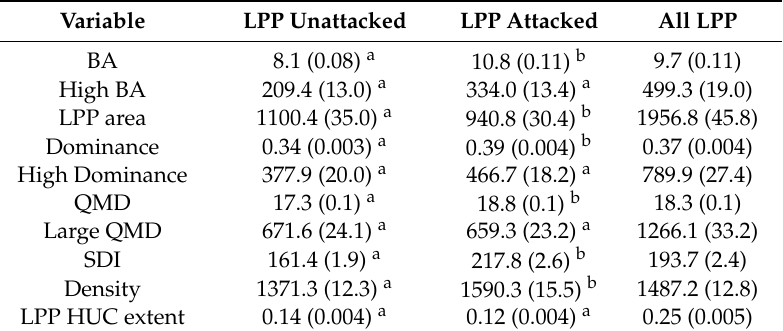
Table 2. Mean (s.e.) of stand host characteristics for attacked, unattacked, and all lodgepole pine (LPP) by subwatershed ( n = 2262). Different superscript letters indicate significantly different values between unattacked and attacked LPP ( p ≤ 0.05). See Table 1 for variable descriptions.